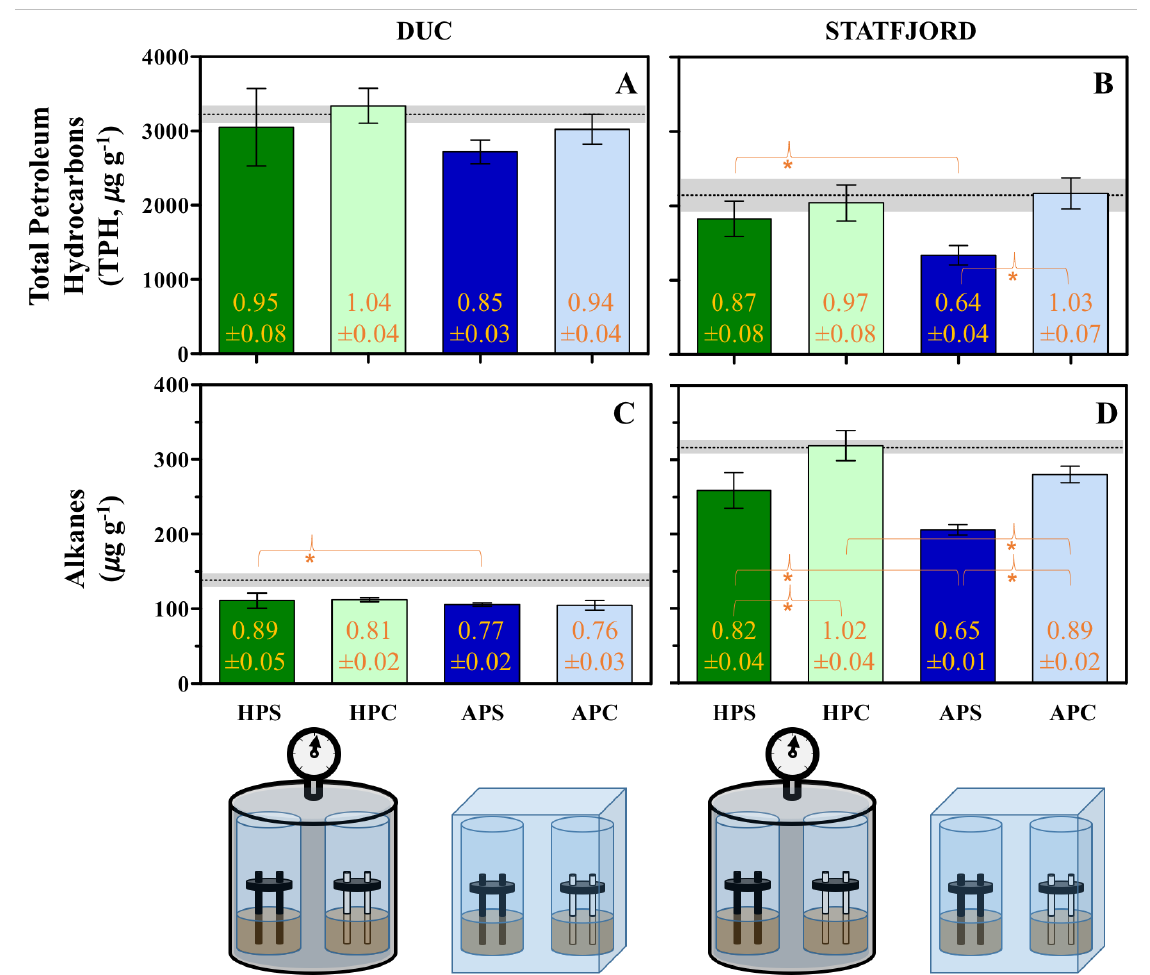
Figure 1. Final concentration ( µ g g − 1 dry weight sediment) of total petroleum hydrocarbons ( A , B ) and alkanes (between C 8 and C 33 ; ( C , D )) at the end of 7 weeks of incubation in sediments contaminated with either Danish Underground Consortium (Duc) ( A , C ) or Statfjord ( B , D ) oil (n = 3; bars represent standard errors). Contamination levels at time zero are reported as horizontal dotted lines, with the grey areas representing the standard error (n = 3; data in Table S1). Degradation was assessed as the relative decrease with respect to the concentration at time zero (C/C 0 ), and is reported in orange for each condition. Abbreviations reported in the graph: HPS, high pressure with snorkels; HPC, high pressure with glass controls; APS, ambient pressure with snorkels; APC, ambient pressure with glass controls. Asterisks indicate statistically significant difference between the bars located at the two extremes of the parenthesis.